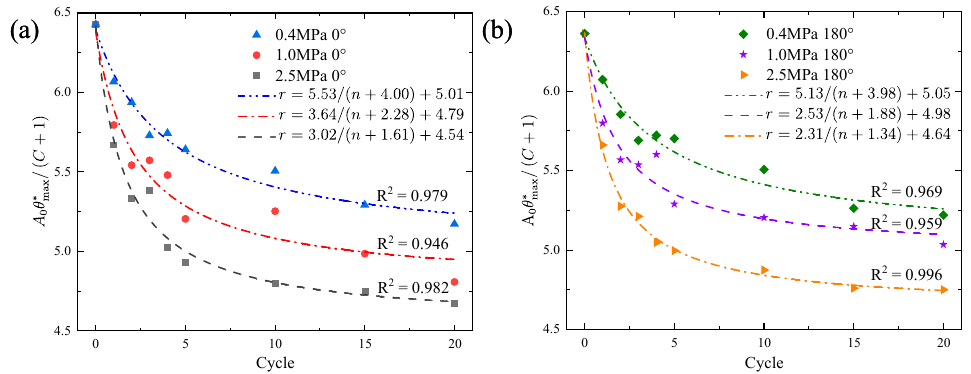
Figure 15. Roughness parameter change process along cyclic shear directions under different normal stresses: ( a ) 0° and ( b ) 180° analyzed directions.